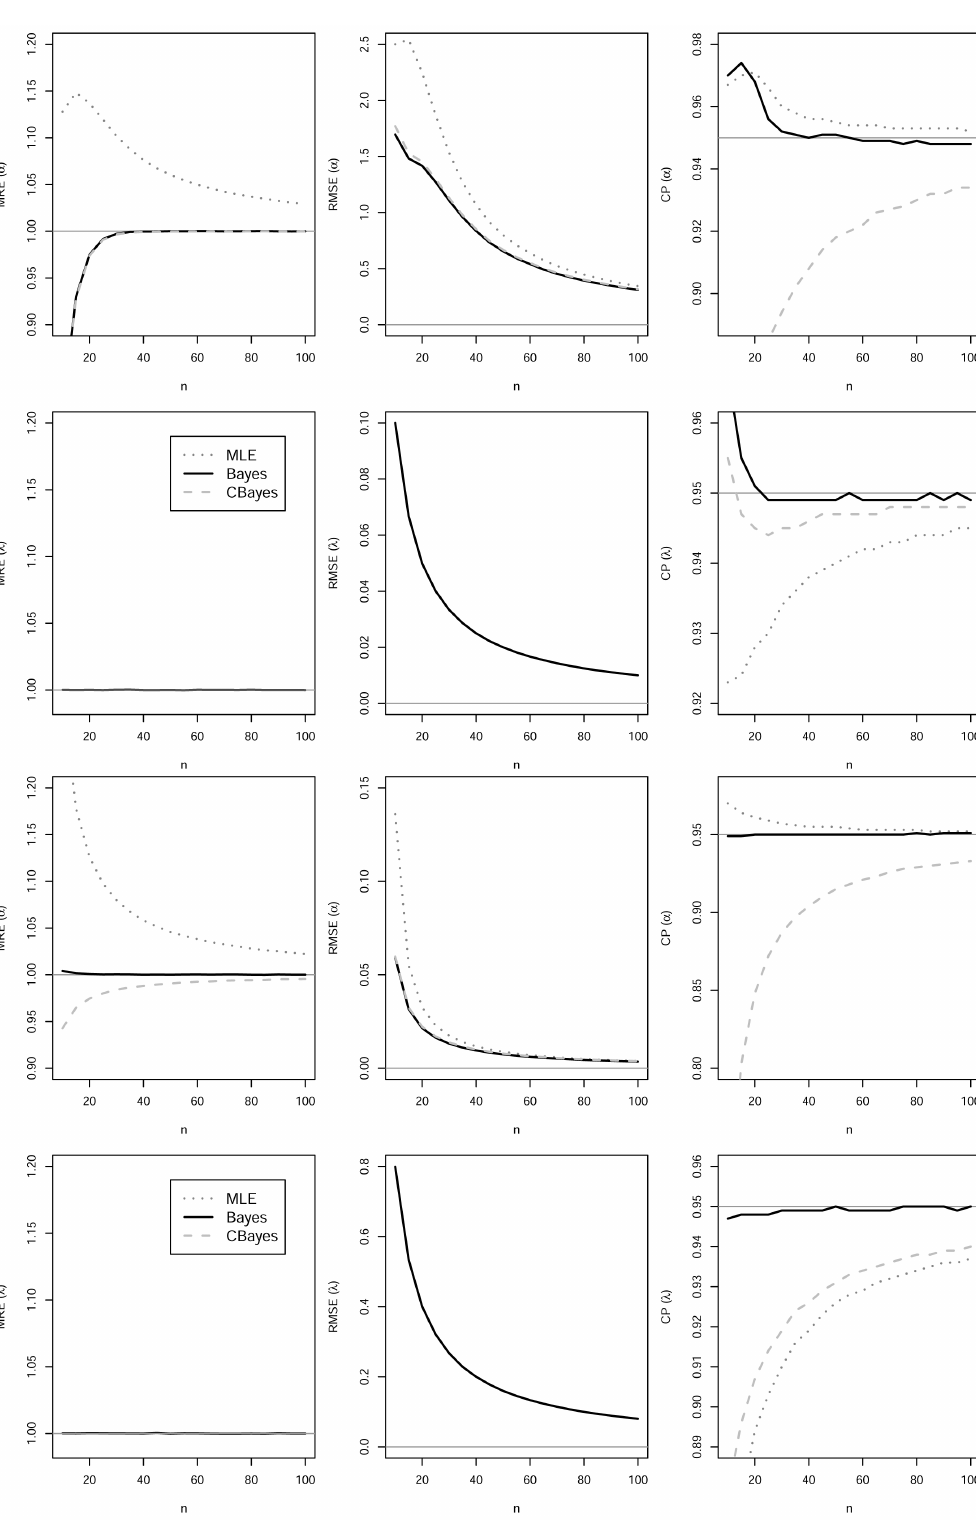
Figure 3 - MREs, RMSEs and CPs for α and λ considering α = 4, λ = 2 (upper panel) and α = 0.5, λ = 2 (lower panel) for N = 100,000 simulated samples and n = (15,20, ... ,100) .